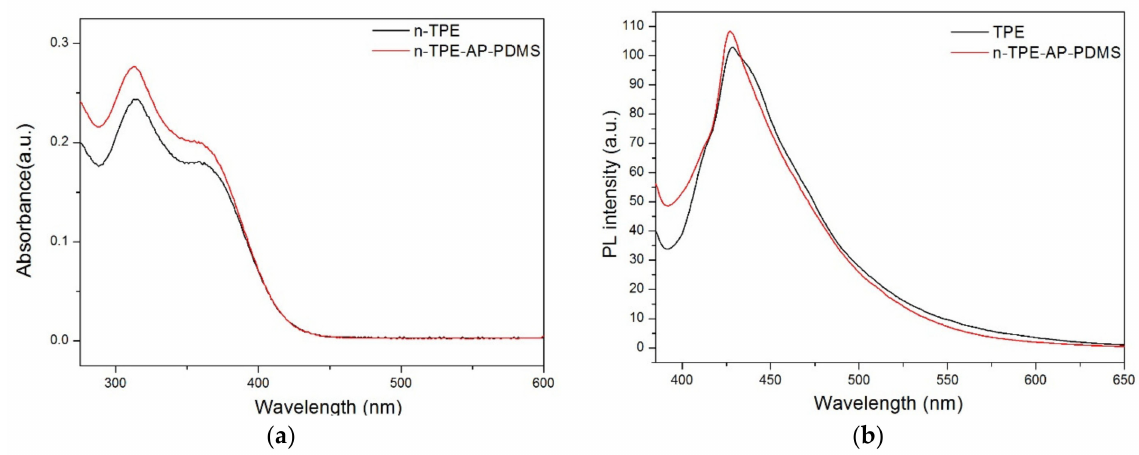
Figure 2. ( a ) The UV–vis absorption spectra of n-TPE and n-TPE-AP-PDMS in THF; ( b ) The photoluminescence (PL) spectra of n-TPE and n-TPE-AP-PDMS in THF; λ ex = 375 nm; concentration: 10 µ